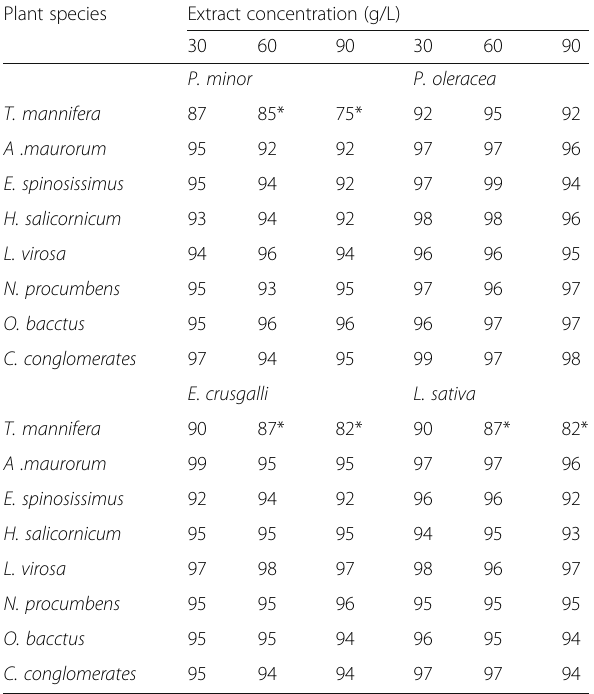
Table 4 Effect of plant extracts (% of control) on growth of 6- week-old P . minor , P . oleracea , E crusgalli , and L. sativa Plant